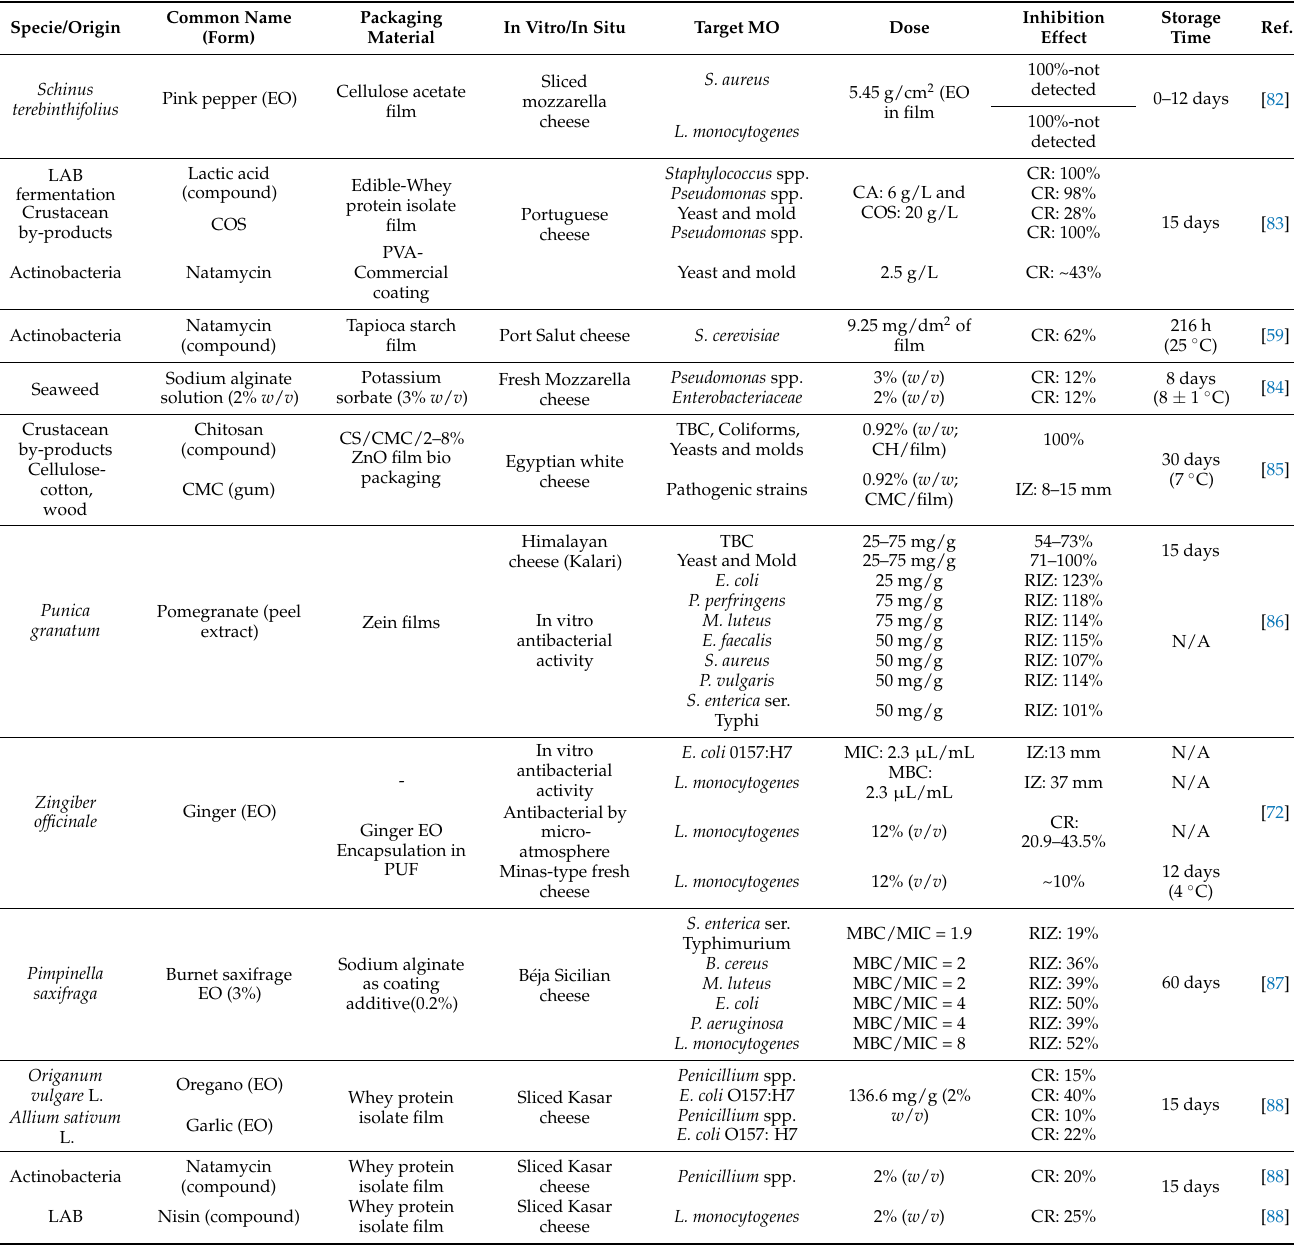
Table 4. Active coating/packaging technology loading natural antimicrobials as a green preservative method extending cheese’s shelf